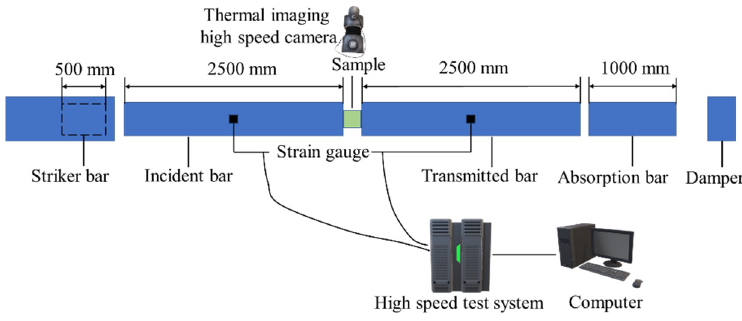
Figure 4. Schematic diagram of the separated Hopkinson compression bar.